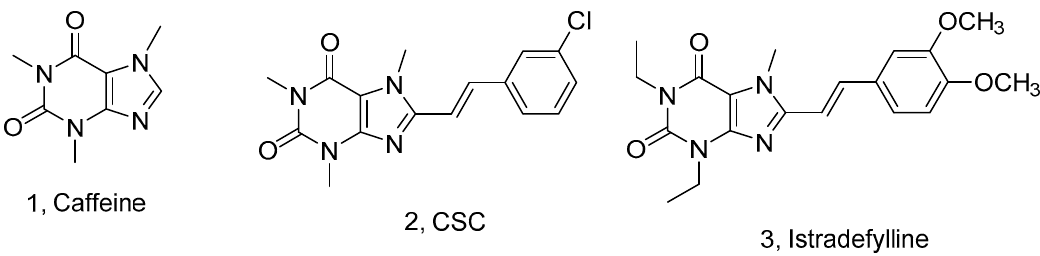
Figure 1. The structures of adenosine A2AR antagonists caffeine ( 1 ), CSC ( 2 ), and istradefylline ( 3 ).